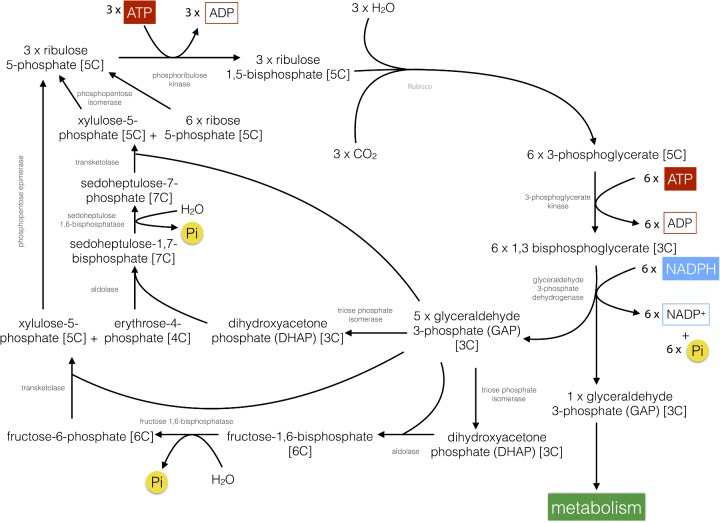
The Calvin–Benson cycleOverview of the biochemical pathway for the fixation of CO2 into carbohydrate in plants.